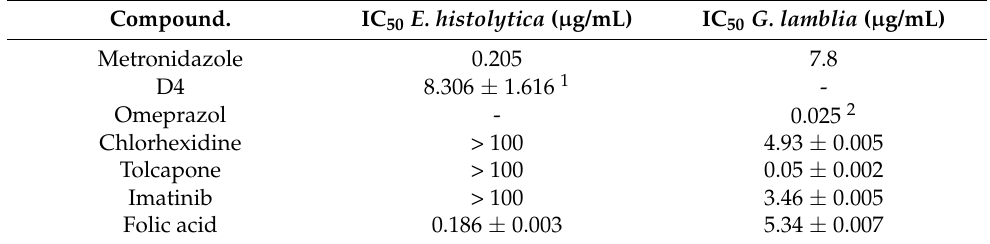
Table 1. Biological activity of four FDA drugs against trophozoites from E. histolytica and G. lamblia .